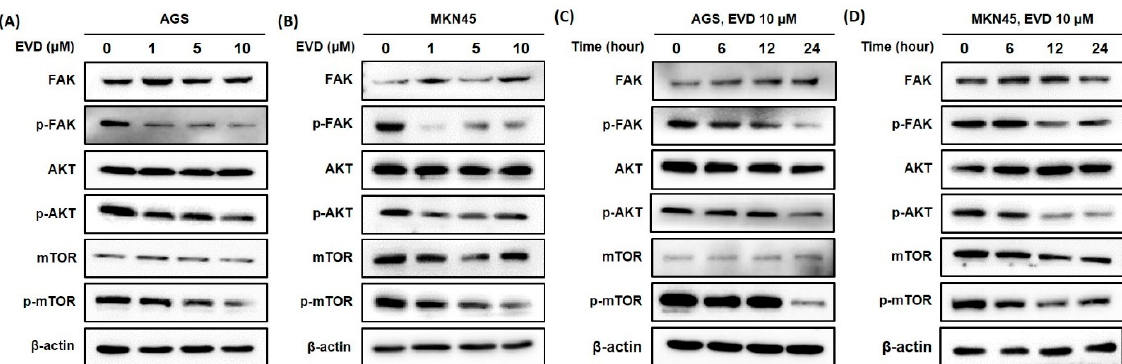
Figure 5. Evodiamine inhibits phosphorylation of FAK, AKT, and mTOR in AGS and MKN45 cells. Indicated doses of evodiamine (0, 1, 5, and 10 μ M) for 24 h were applied to ( A ) AGS and ( B ) MKN45 cells. A total of 10 μ M evodiamine for the indicated time periods (0, 6, 12, and 24 h) were applied in ( C ) AGS and ( D ) MKN45 cells. The cell lysates were subjected to Western blot to evaluate the levels of FAK, p-FAK, AKT, p-AKT, mTOR, and p-mTOR. β -actin was used as an internal control. EVD, evodiamine.